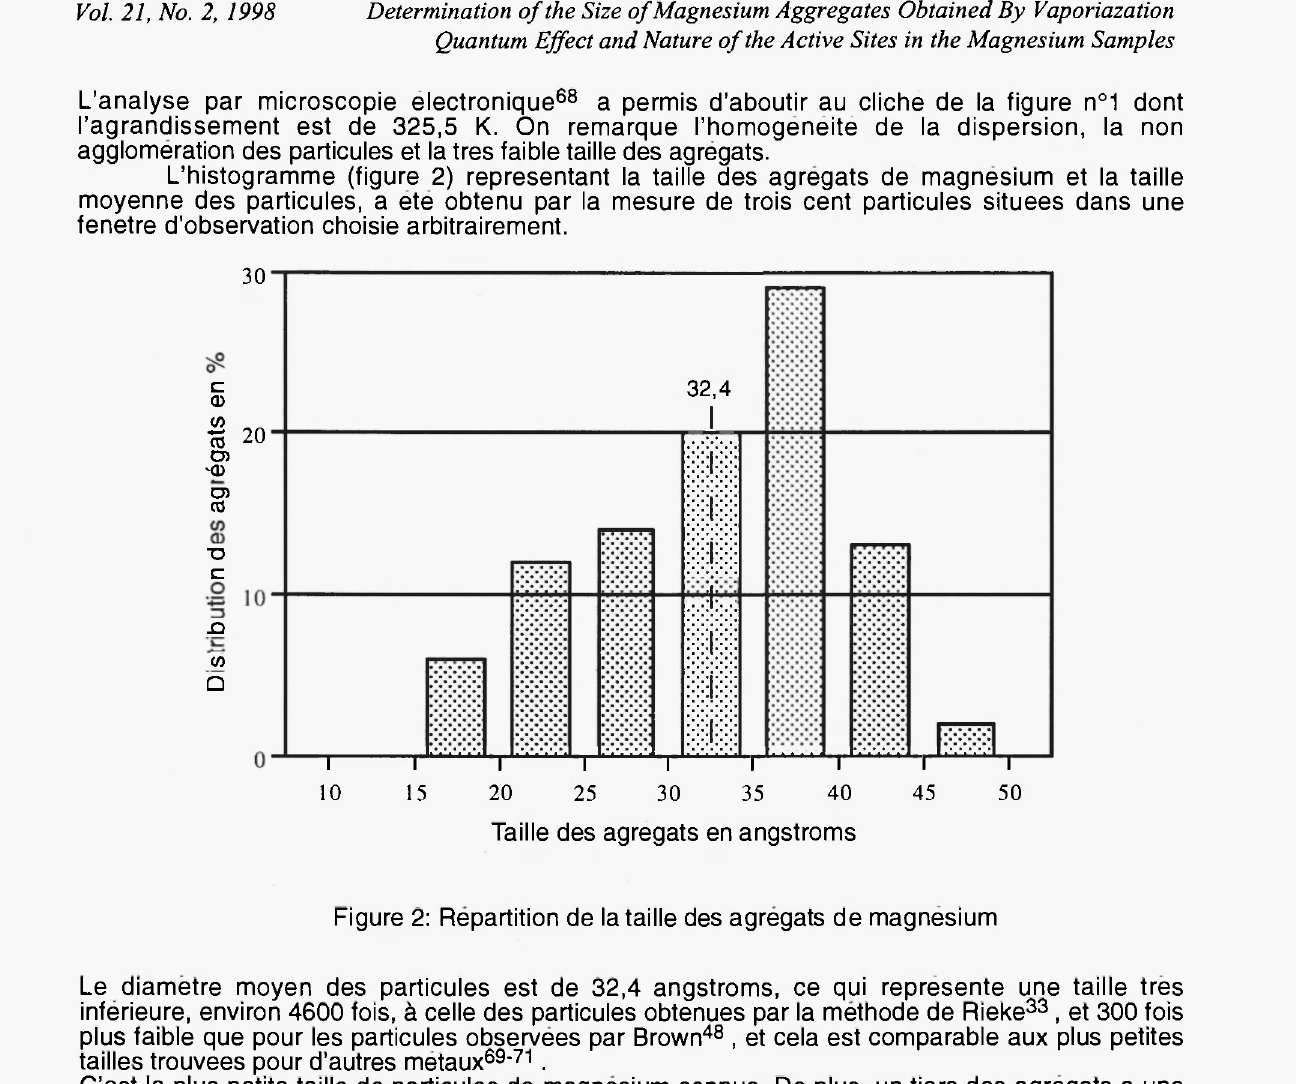
Figure 2: Repartition de la taille des agregats de